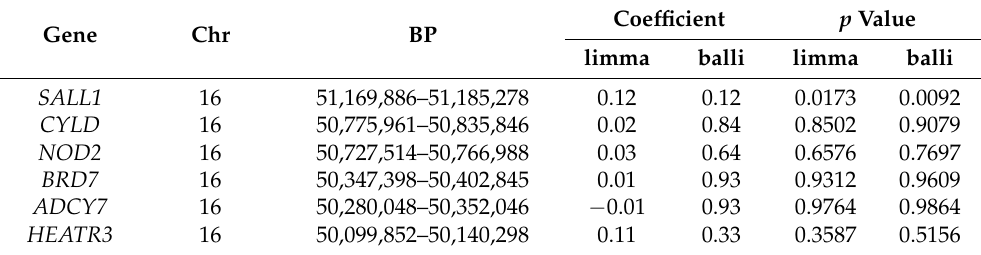
Table 3. Differentially expressed genes analysis from